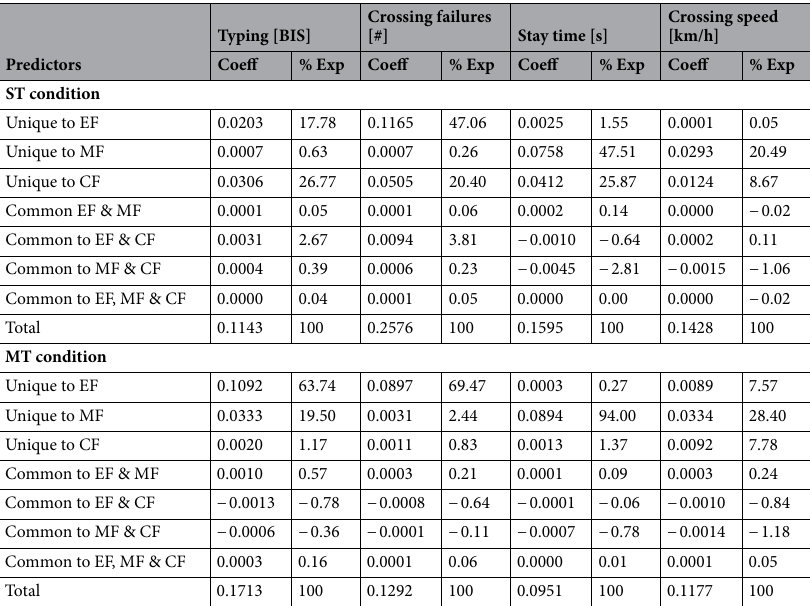
Table 3. Results of the commonality analysis for typing, crossing failures, stay time, and crossing speed. EF executive functions, MF motor coordinative fitness, CF cardiovascular fitness, Coeff commonality coefficients, % Expl proportion of explained variance in